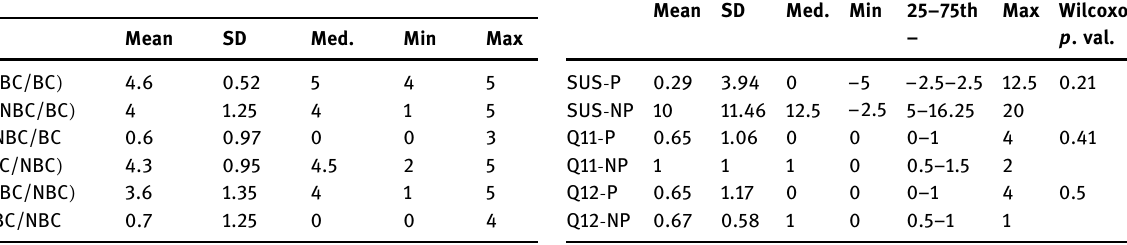
NBC = no behaviour checking, BC = behaviour checking.